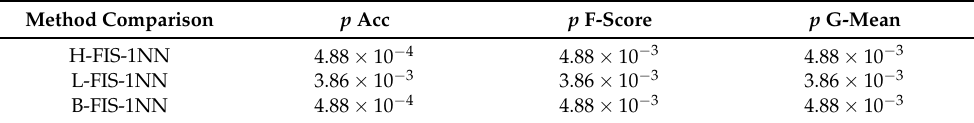
Table 12. Calculated values of p using the Wilcoxon signed-ranks test for the UCI datasets.